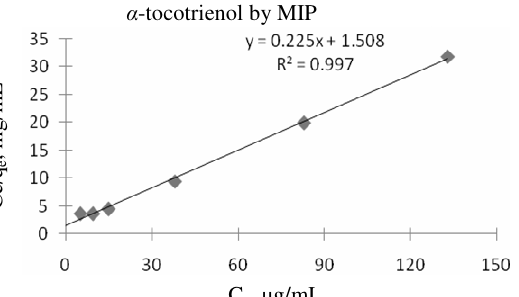
Figure 10. Adsorption isotherms of α -tocotrienol cross-linked chitosan-polyacrylamide MIP beads, linearized according to the Langmuir equation